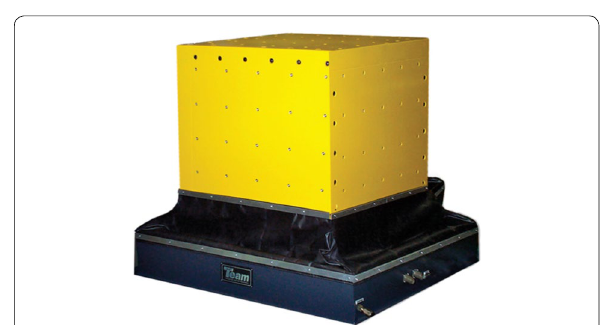
Figure 4 CUBE 6-DOF electro-hydraulic shaking table